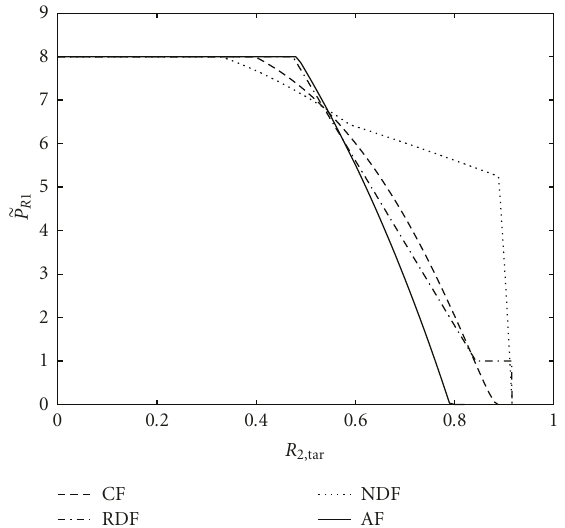
Figure 8: Powers allocated by jointly optimal algorithm in Scenario 2.